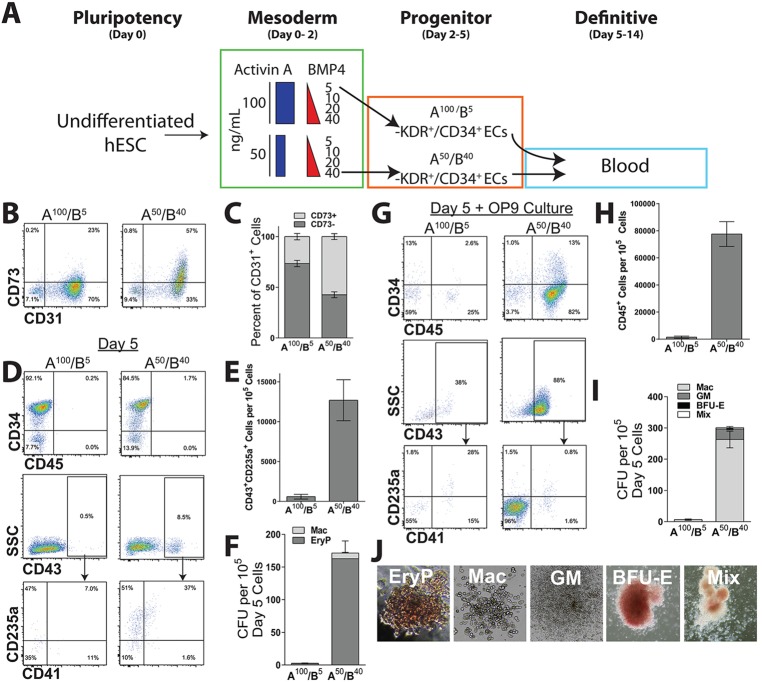
Day 5 ECs have hematopoietic potential. (A) The experimental approach for directing undifferentiated hESCs into A100/B5 and A50/B40 ECs followed by differentiation into blood cells. (B,C) Representative flow cytometry plots (B) and mean percentages (C) of CD73+ and CD73− subsets of CD31+ A100/B5 and A50/B40 ECs (n=6 replicates). (D-F) Representative flow cytometry plots of hematopoietic phenotypes CD34/CD45, CD41/CD235a within the CD43 subset (D), mean numbers of cells of primitive phenotype (CD43+/CD235a+/CD41+/−) (n=6 replicates) (E), and colony-forming assays for primitive hematopoietic progenitors including primitive erythroid (EryP) and macrophage (Mac) (n=3 replicates) (F) generated from day 5 A100/B5 and A50/B40 ECs. (G-I) Representative flow cytometry plots of hematopoietic phenotypes CD34/CD45, CD41/CD235a within the CD43 subset (G), mean numbers of CD45+ hematopoietic cells generated (n=6 replicates) (H), and colony-forming assays for definitive erythroid/myeloid hematopoietic progenitors including macrophage (Mac), granulocyte/monocyte/macrophage (GM), large, burst-forming erythroid (BFU-E), and mixed erythroid/myeloid (Mix) colonies (n=3 replicates) (I) generated from 105 A100/B5 ECs or A50/B40 ECs following 12-14 day secondary culture on OP9 cells. (J) Representative images for colony-forming assays. Images are magnified for EryP (100×) and Mac (50×) to show details of colony morphology.